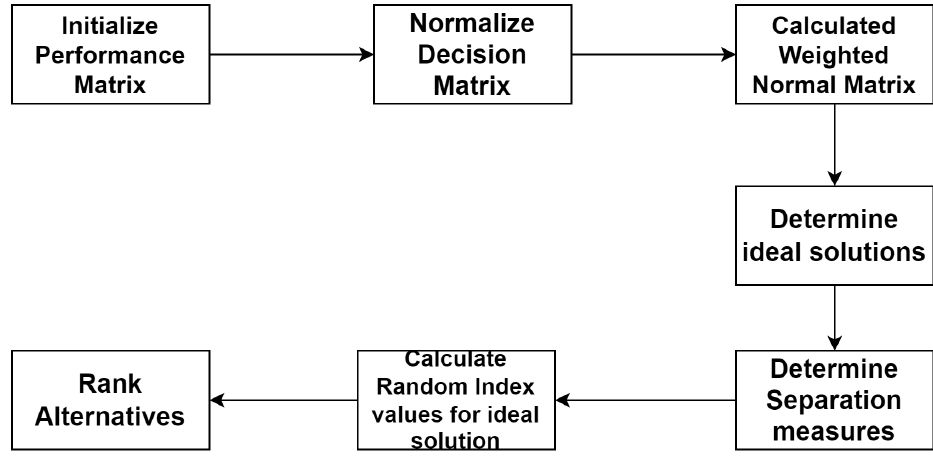
Figure 8. Methodology of